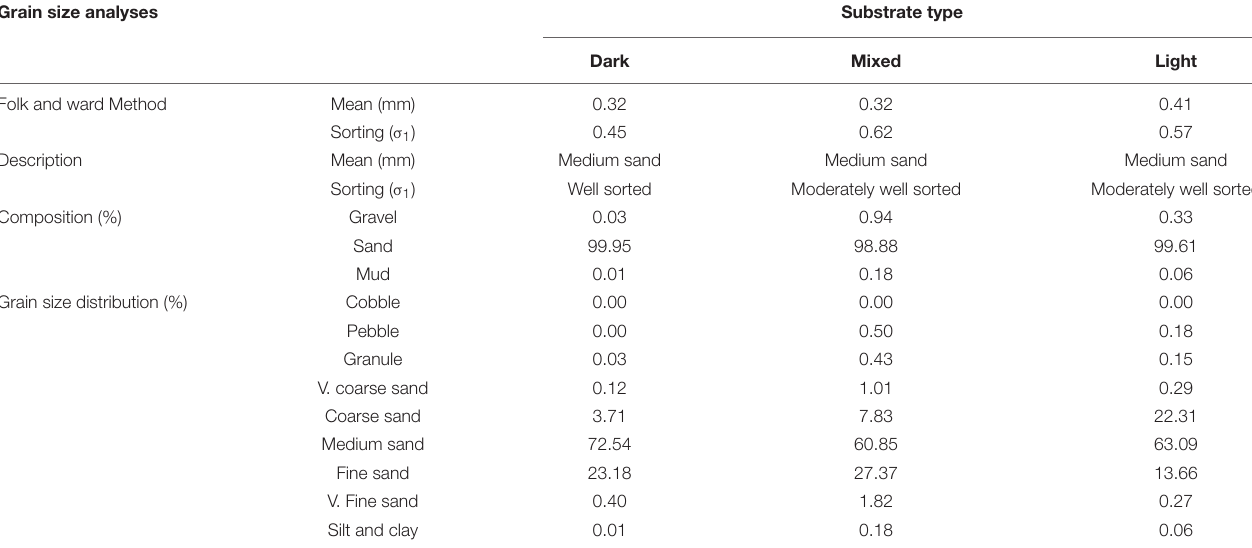
TABLE 4 | Grain characterisation and composition within the three different substrate